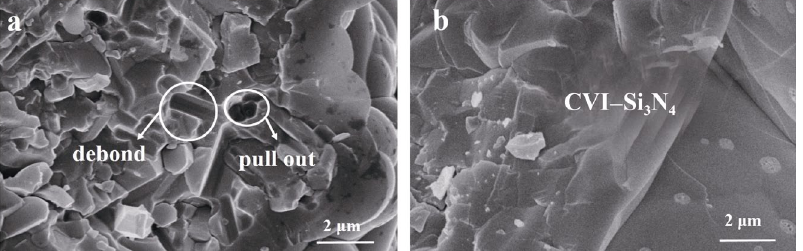
Fig. 7 High-resolution fracture morphologies of porous Si 3 N 4 –Si 3 N 4 composite ceramics as a function of deposition time: (a) 3 and (b) 12 h. the uniform and effective distribution of applied